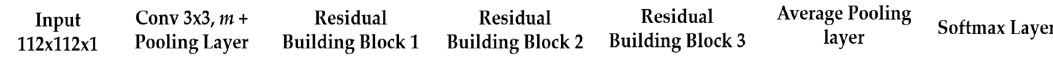
( b ) Figure 10. ( a ) Projections of the data from the SNPHEp-2 dataset; ( b ) The zooming of the part surrounded by the red circle in ( a ). Concerning the hyperparameters used during the training, different scenarios were used in order to optimize the discrimination results. These hyperparameters were selected via cross- validation using different splits, as clearly explained previously. All the following values concerning the hyperparameters are the ones that have provided the best results during the experiments. The initial learning rate was set to be 0.1 at the beginning of the training process. This value was then divided by a factor of 10 every 50 epochs. This schedule, as usually done in the literature with deep learning structures, aims to update the weights quickly at the beginning of the training process while the loss (error) is quite big, and then slowing down the update process, by decreasing the learning rate, when the loss decreases. The learning is terminated when the loss plateaus and does not change after decreasing the learning rate. The size of the mini-batch was set to be 128. The momentum was set to 0.9 and we have initialized the weights by following the process presented by He et al. [33]. All the experiments were conducted with MATLAB R2018b and performed on a computer with a Core i7 3.40 GHz processor and 8 GB of RAM. A GPU implementation was used with a NVIDIA GeForce GTX 1080 Ti with 11,264 MB of memory, which accelerates the training time. We start by the results obtained using one single network that takes the original images as the input. The structure of this network follows the same structure of the proposed method, except the fact that there is no summation layer because there is only a single network. The network structure